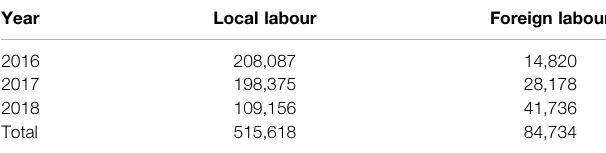
TABLE 1 | Numbers of foreign labour in Malaysia ’ s construction industry. TABLE 2 | Statistic of registered personnel by